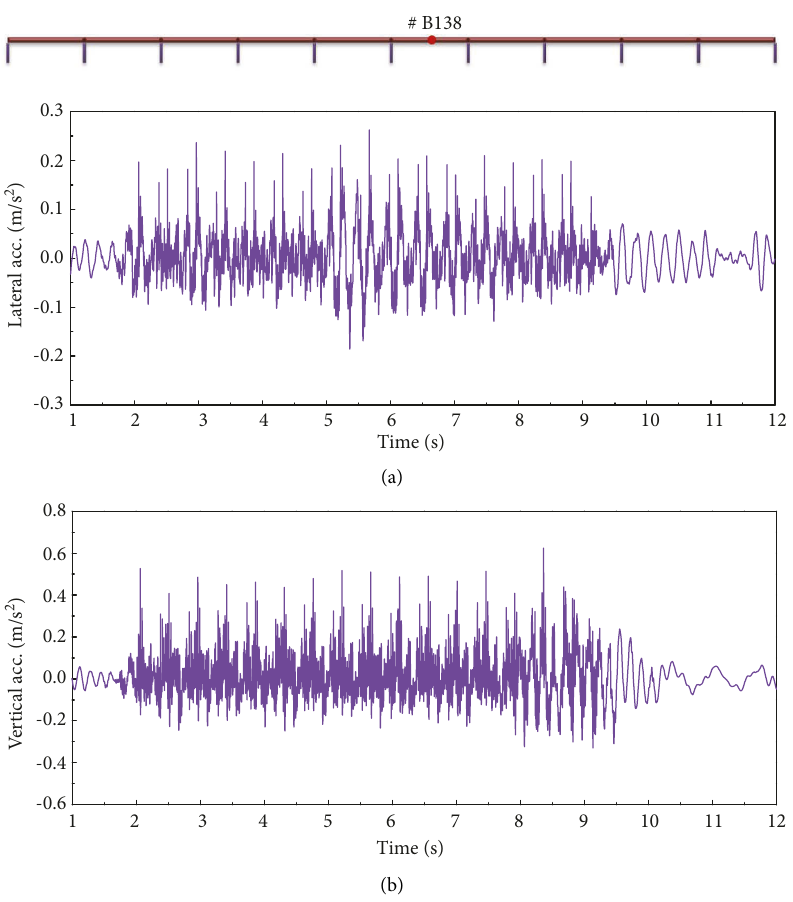
Figure 11: Acceleration time histories of node B138. (a) Lateral acceleration. (b) Vertical